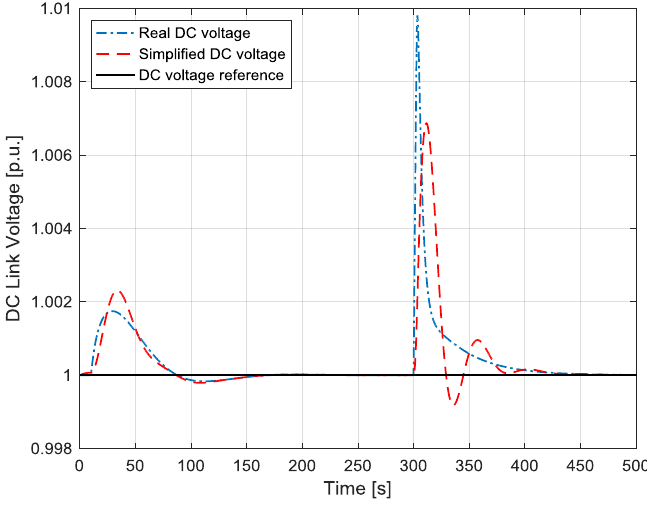
Figure 21. DC voltage time profile.